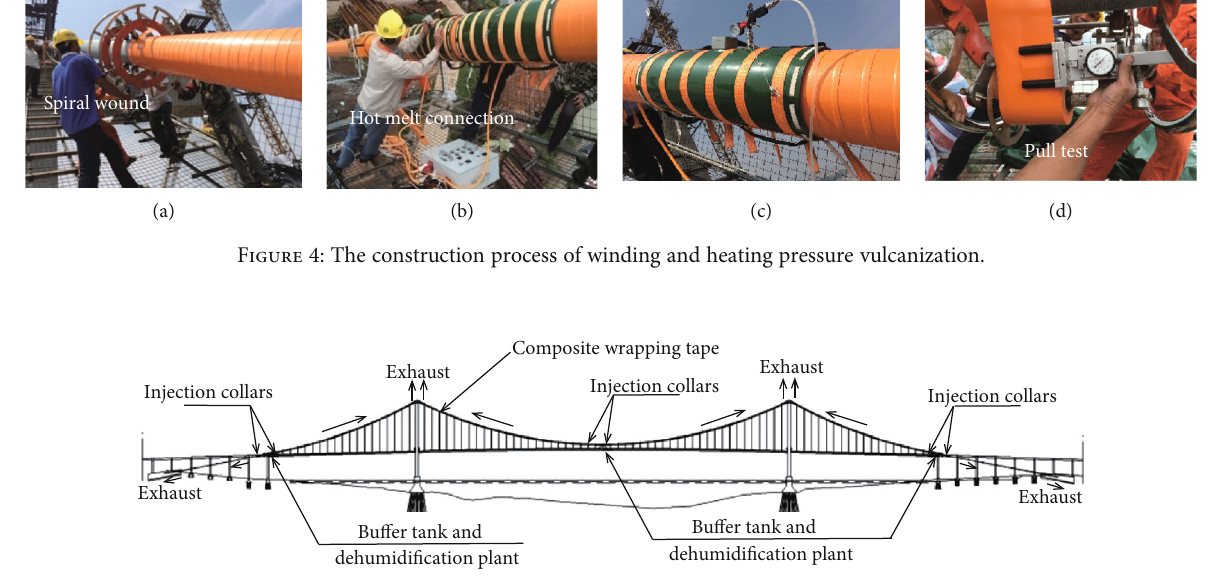
Figure 5: Principle of dehumidi fi cation and protection of the main